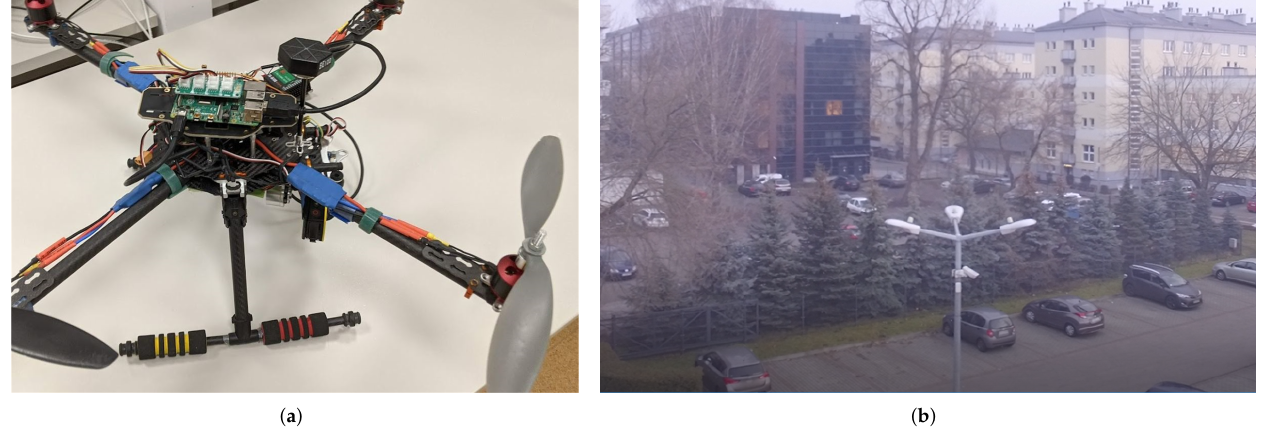
Figure 1. The Kestrel: ( a ) the air station of the UAV and WebRTC-based universal framework standing on the laboratory table; ( b ) the Kestrel when working in its “natural environment” (a picture captured from the Manta MM9359FS